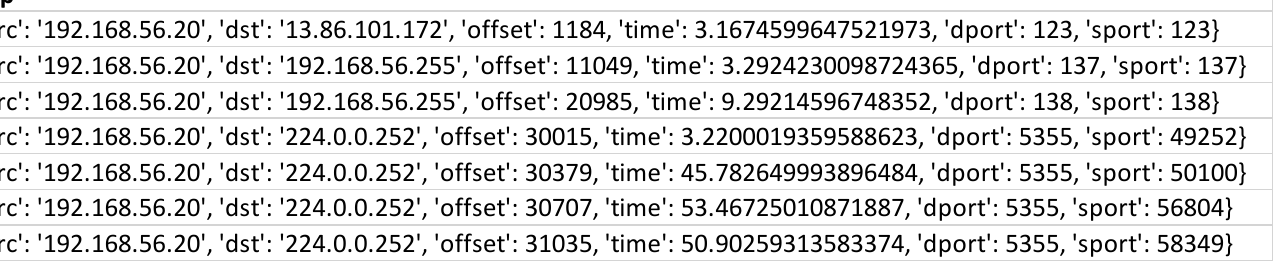
Figure 5. Dataset rows corresponding to a “UDP” feature of an artifact.